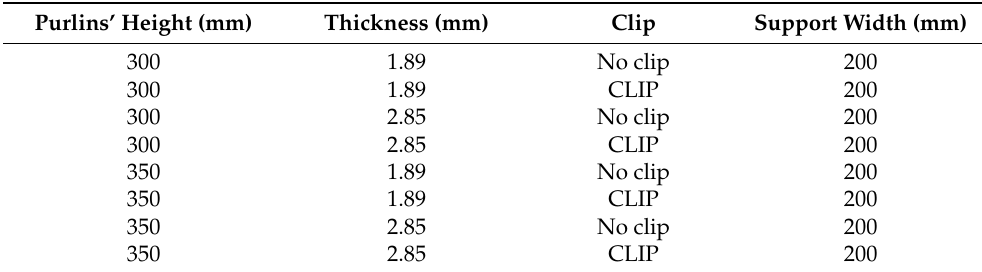
Table 2. Experiment schedule and